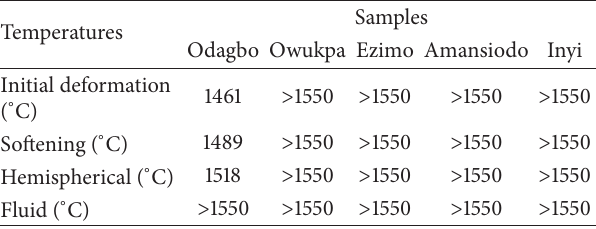
Table 5: Results of ash fusion temperature test (in oxidizing atmosphere) of the five coal samples.